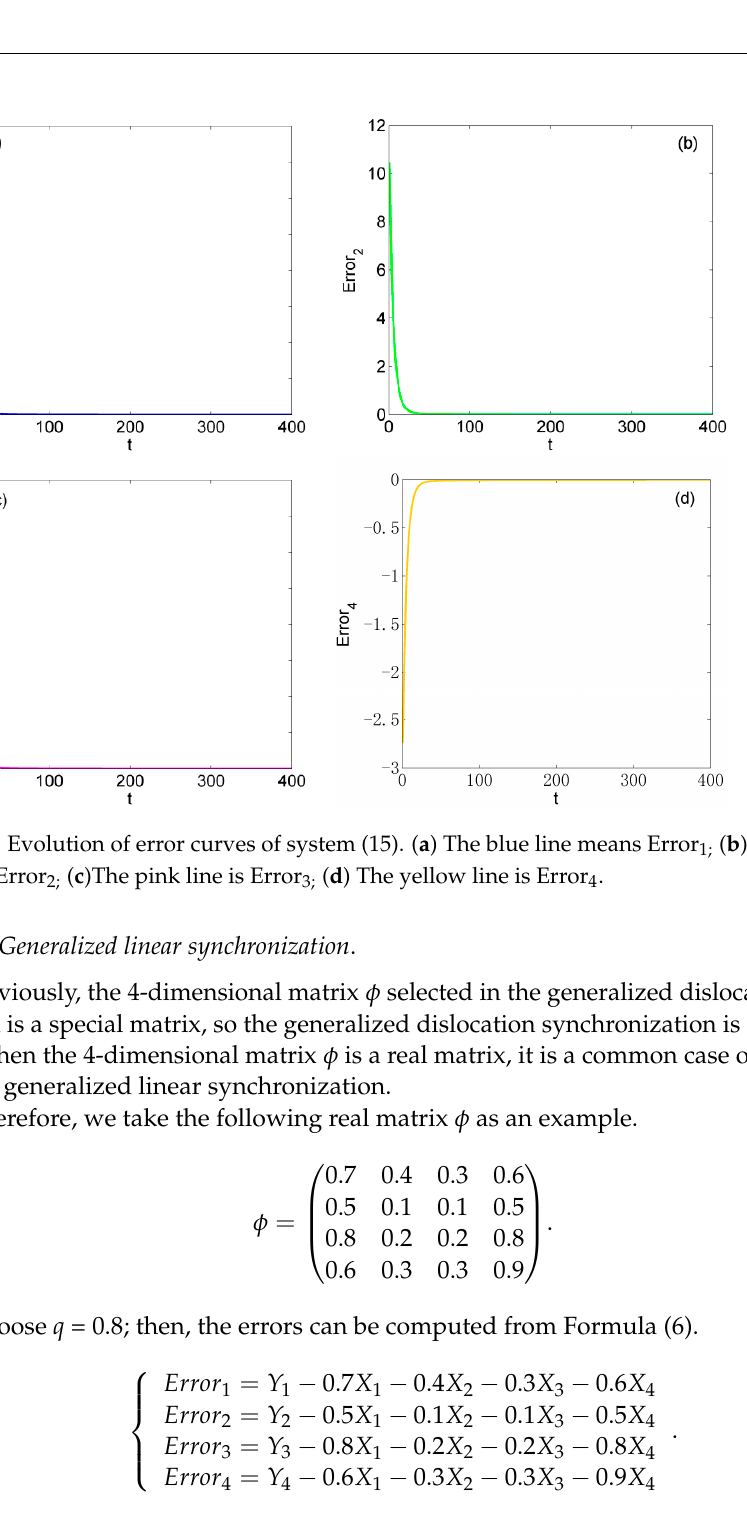
Figure 5. Time series diagram and synchronization plots of generalized dislocation synchroniza ‐ tion. (a,c,e,g) Time series diagrams. (b,d,f,h) The synchronization plots. In (a), the blue line is X 2 and the red line is Y 1 . In (c), the blue line and the red line means X 1 and Y 2, respectively. In (e), the blue line and the red line means X 4 and Y 3, respectively. In (g), the blue line and the red line means X 3 and Y 4, respectively.